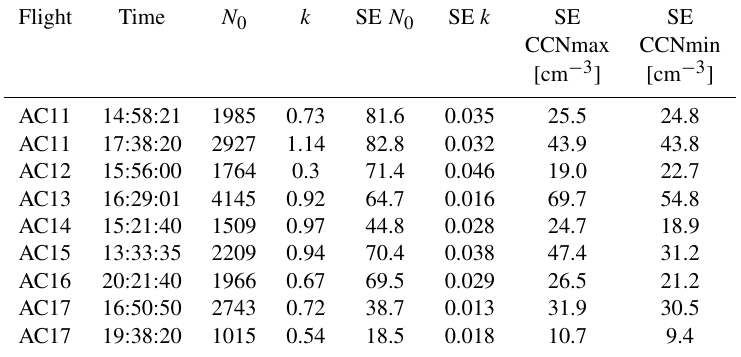
Table 2. Estimates of N 0 and k below cloud base and their standard error (SE) for each case study. Maximum and minimum SE (SE CCNmax and SE CCNmin, respectively) for the CCN measurements are calculated considering errors in the supersaturation measurements ( ∼ 10%). The details about the calculation of these values are given in Appendix B.